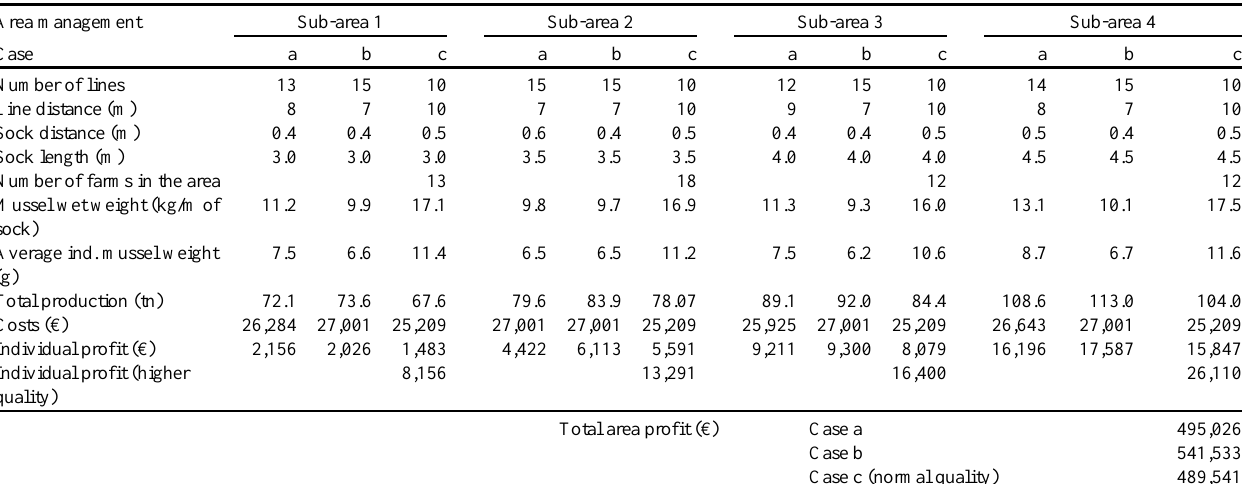
Table 7 . Farming techniques examination: (A) random case, (B) excessive case, and (c) regulated case.